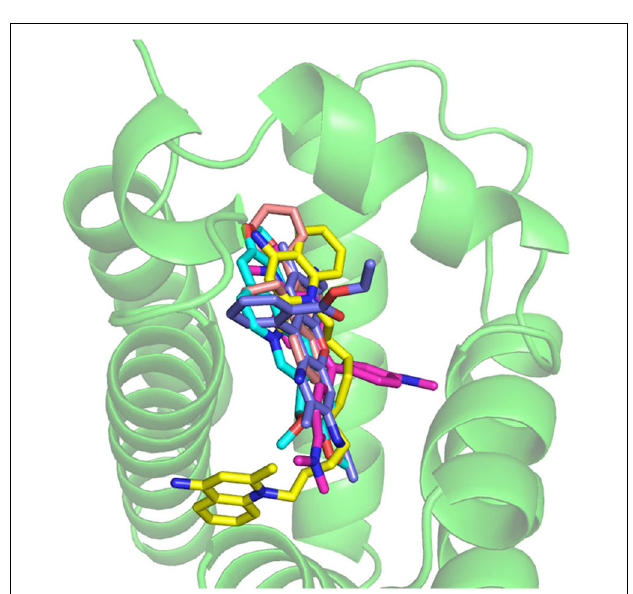
FIGURE 7 | The co-crystal structure of the RamR protein with multiple cationic aromatic compounds. The RamR protein recognizes multiple compounds via multisite